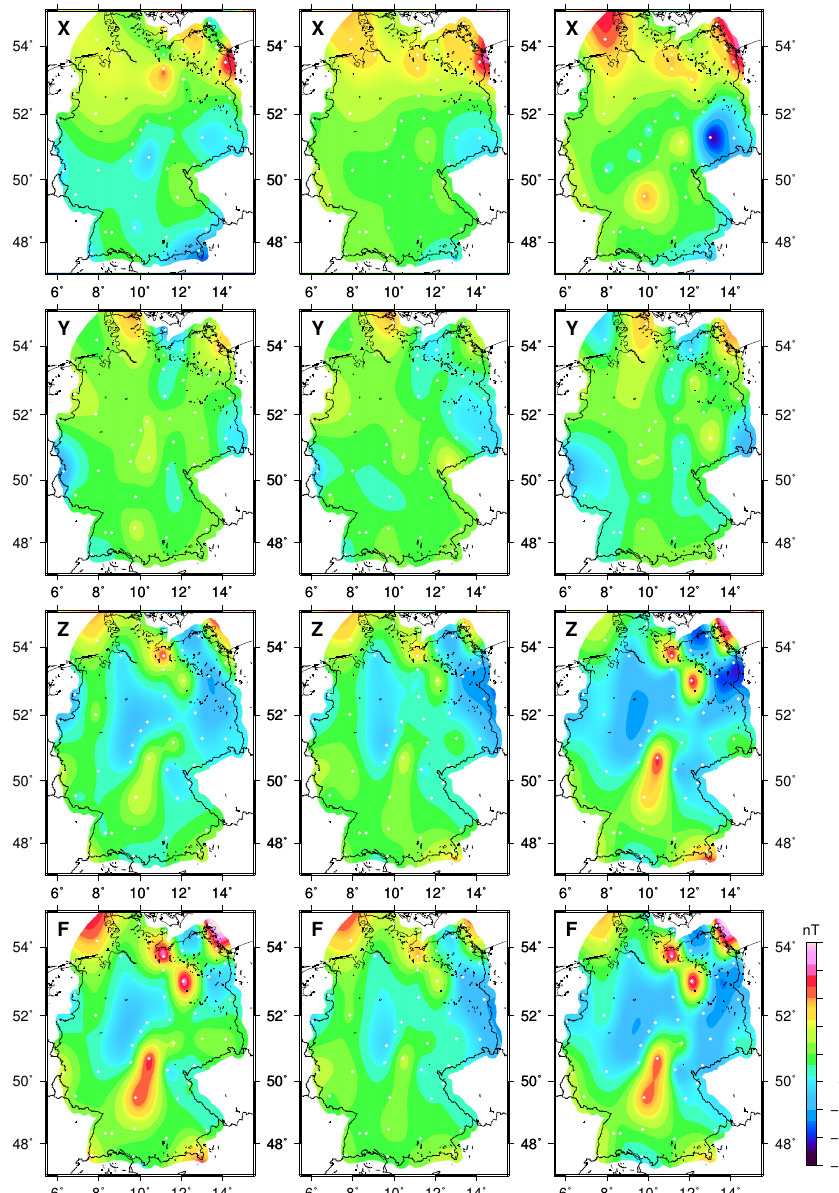
Figure 7. Estimates of lithospheric anomaly values at ground station locations, interpolated in the same way for a visual comparison (not reflecting the actual shape or dimension of anomalies). Orthogonal component estimates based on the R-SCHA model and total field anomaly values from the dense grid by Gabriel et al. (2011) (left), predictions from the EMM2010 model of SH degrees 15–720 (middle), and ground data processed as described in Sect. 2.1.2 (right). North ( X ), east ( Y ), vertical ( Z ), and total field ( F ) components from top to bottom and colour scale the same as in Fig.